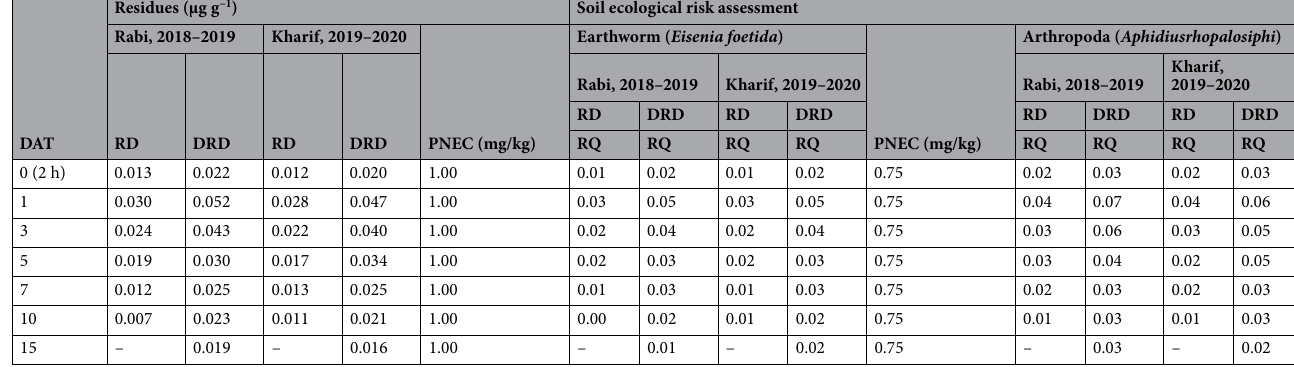
Table 7. Ecological risk assessment of chlorantraniliprole 18.5% SC in soil. DAT days after treatment, RD recommended dose (30 g a.i./ha), DRD double the recommended dose (60 g a.i./ha), PNEC predicted no effect concentration, RQ risk